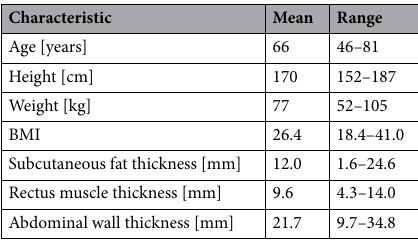
Table 2. Baselines patient characteristics.